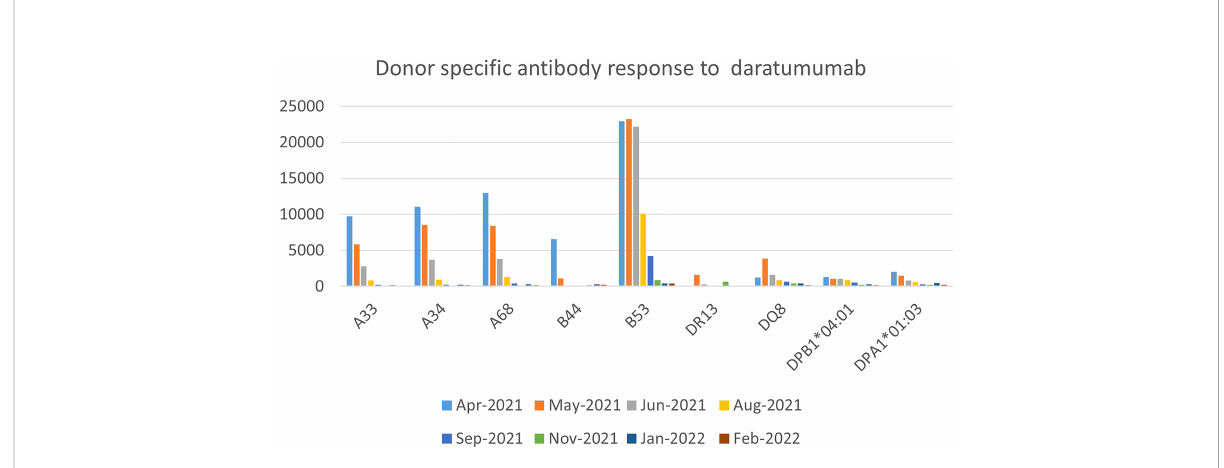
FIGURE 2 Donor speci fi c antibody response to